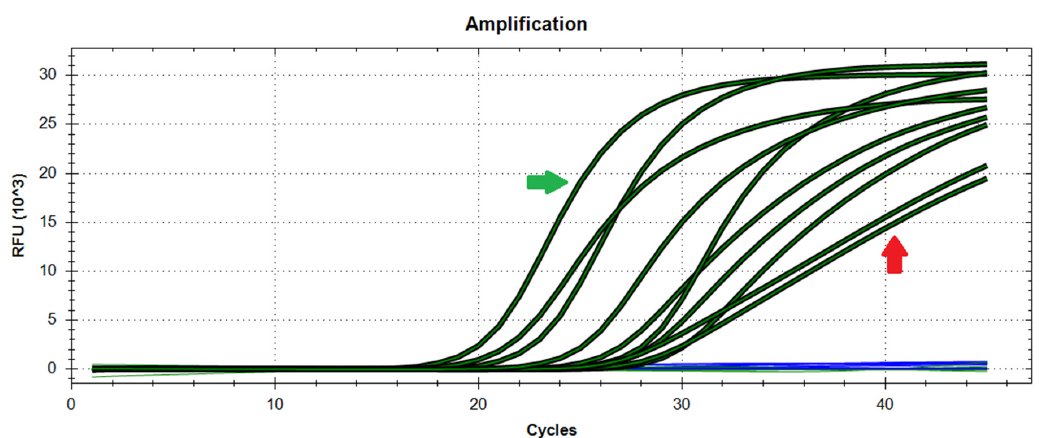
Figure 4. Difference between genuinely positive and contaminated samples. The curves to the left of the plot are from samples that are genuinely positive (green arrow), whereas two curves to the right are perfectly linear and suggest a contamination event (red arrow). Blue lines represent samples that have not generated amplification.